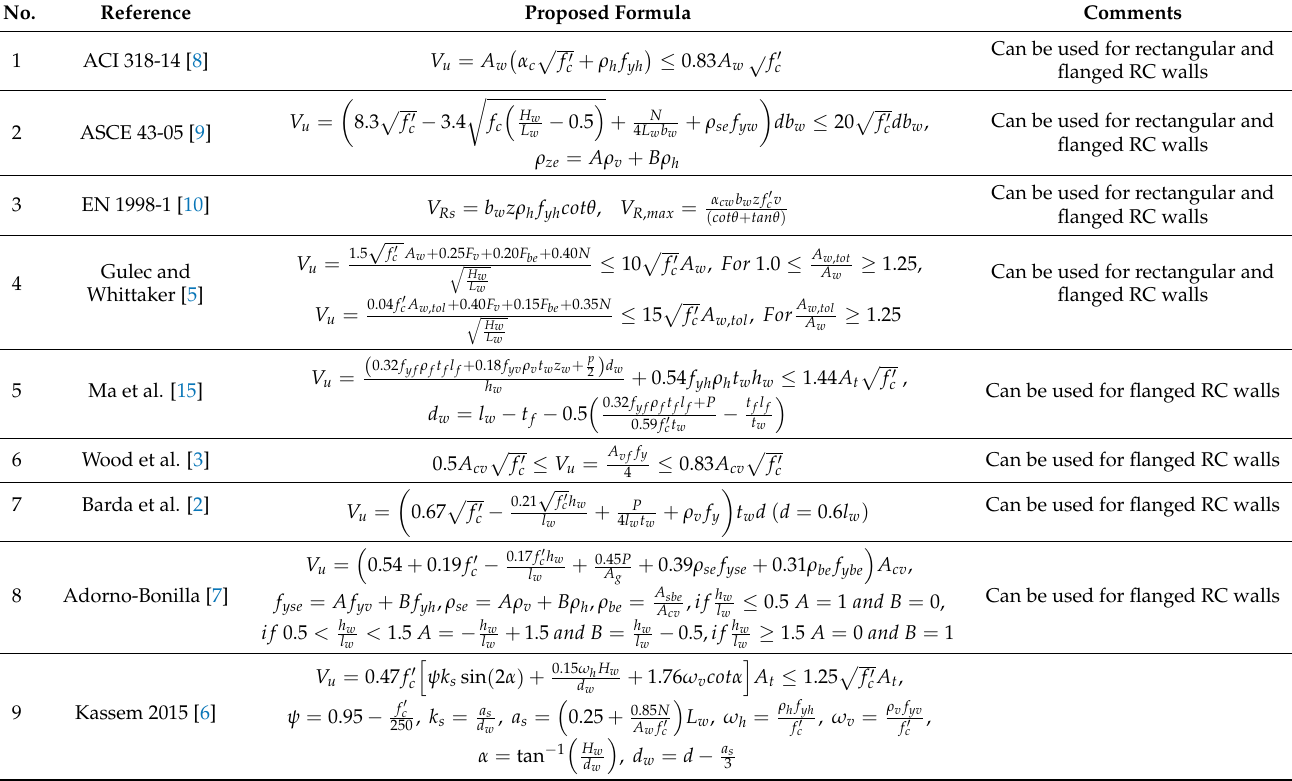
Table 1. Previously proposed shear strength models of RC squat